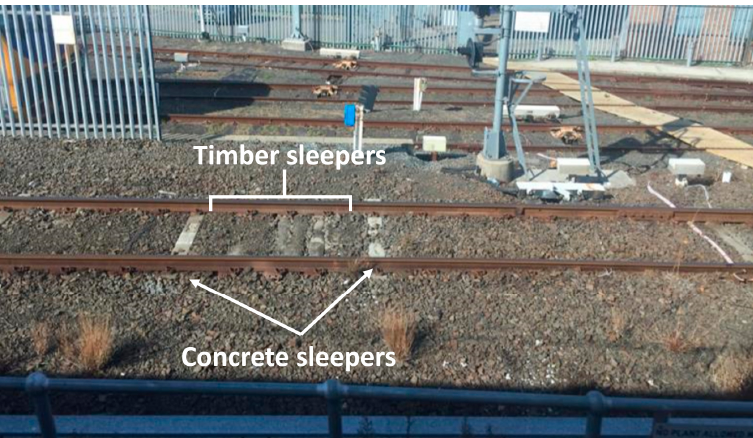
Figure 1. An interspersed railway track [6, 18–21].